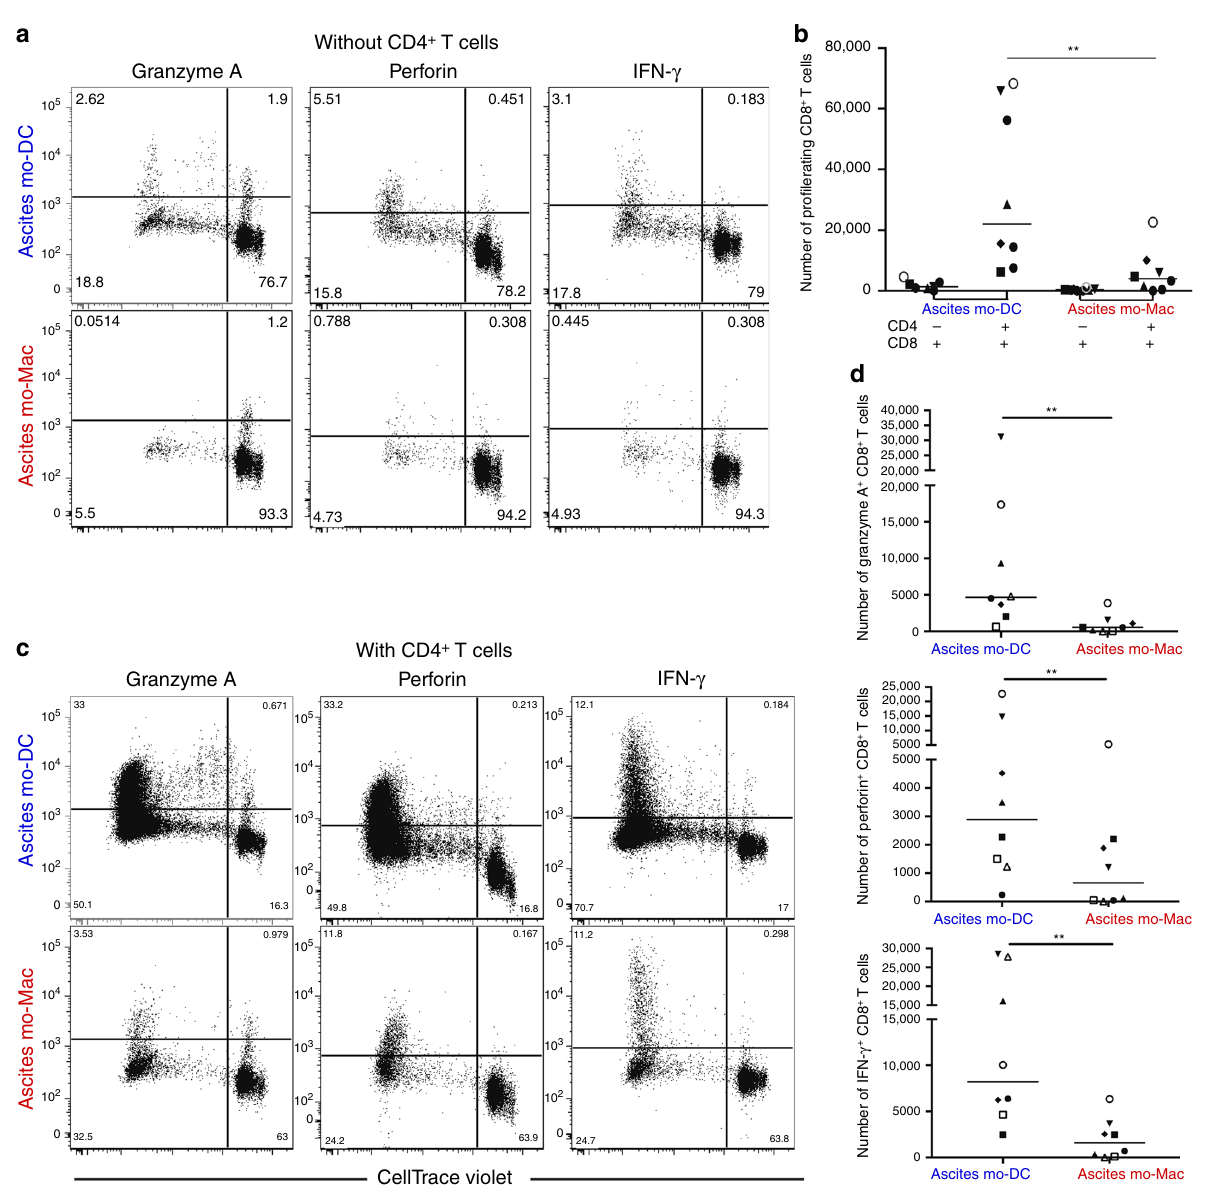
Fig. 6 Human mo-DCs, but not mo-Mac, are ef fi cient inducers of effector cytotoxic CD8 + T cells. Puri fi ed DCs and macrophage from tumor ascites were cultured with allogeneic CellTrace Violet-stained naïve CD8 + T cells for 7 days, in the absence ( a , b ) or presence ( c , d ) of naïve CD4 + T cells autologous to CD8 + T cells. Expression of Granzyme A, Perforin, and IFN- γ was assessed by intracellular fl ow cytometry. a , c Representative results of eight independent experiments. Gated on live CD8 + T cells. b Number of proliferating CD8 + T cells is shown. Symbols represent individual donors. N = 8. Median is shown. d Number of CD8 + T cells expressing effector molecules is shown. Symbols represent individual donors. N = 8. Median is shown. * p < 0.05, ** p < 0.01, Wilcoxon non-parametric molecular requirements for cross-presentation are different between mouse cDC1 and mo-DCs both in vivo and in vitro 51,52 . Our results extend these observations to human DC subsets.